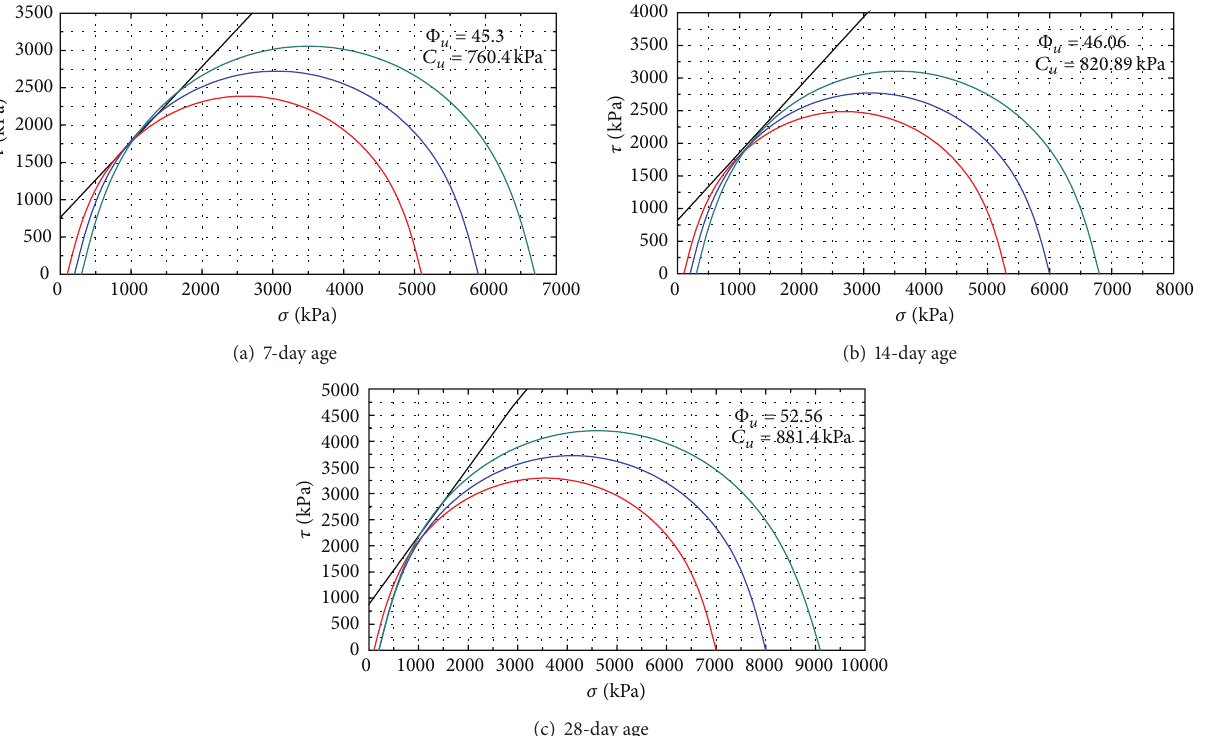
Figure 8: Polypropylene fiber content 0.5% unconsolidation undrained shear strength